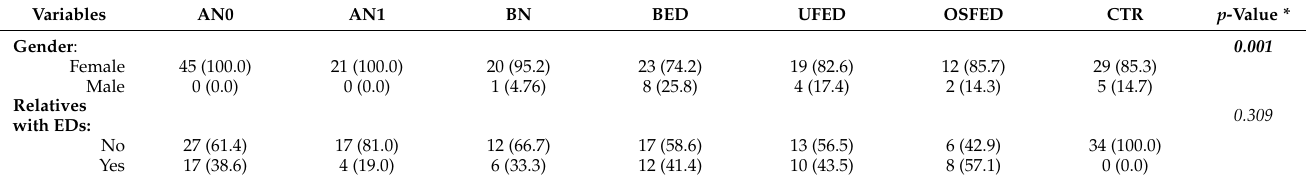
Table 1. Sociodemographic and anthropometric characteristics of EDs and control group. Summary descriptive table by groups of diagnosis expressed as median (q1 = first quartile; q3 = third